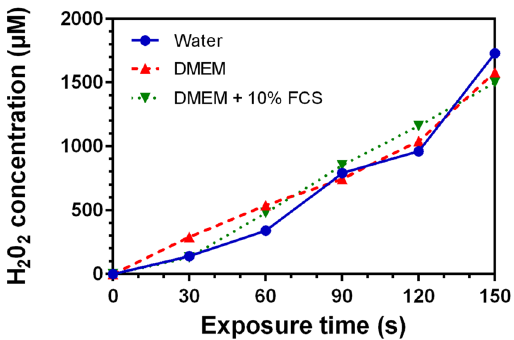
Figure 4. Variation of the concentration of hydrogen peroxide in Milli-Q water, DMEM and DMEM + 10%FCS as a function of He plasma jet time